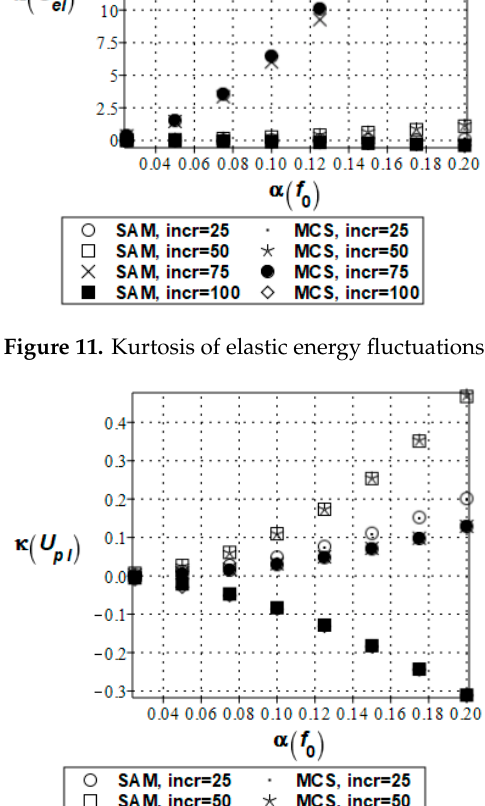
Figure 12. Kurtosis of plastic energy fluctuations.